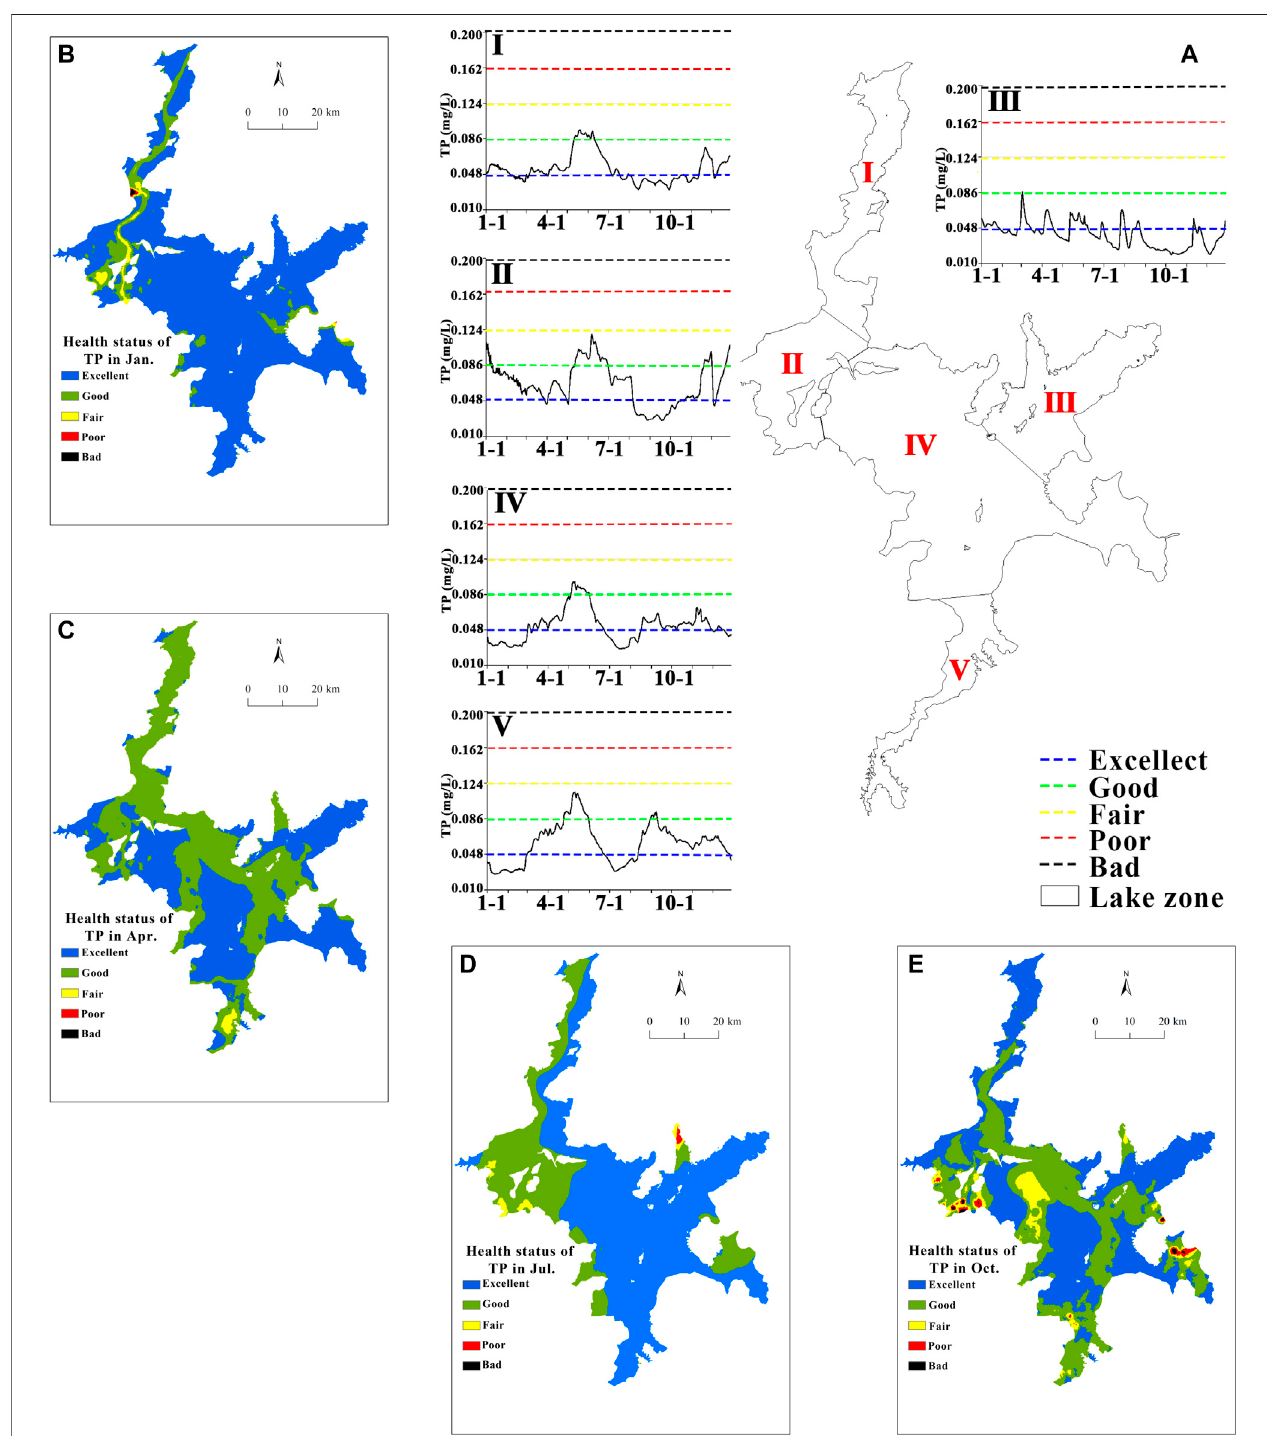
FIGURE 8| Real-time health assessment curves and spatiotemporal distributions ofTP in the lake zones ofLake Poyang in 2015. (A) real-time health assessment curves of TP, (B – E) spatiotemporal distributions of TP in Jan.,Apr.,Jul.,Oct.